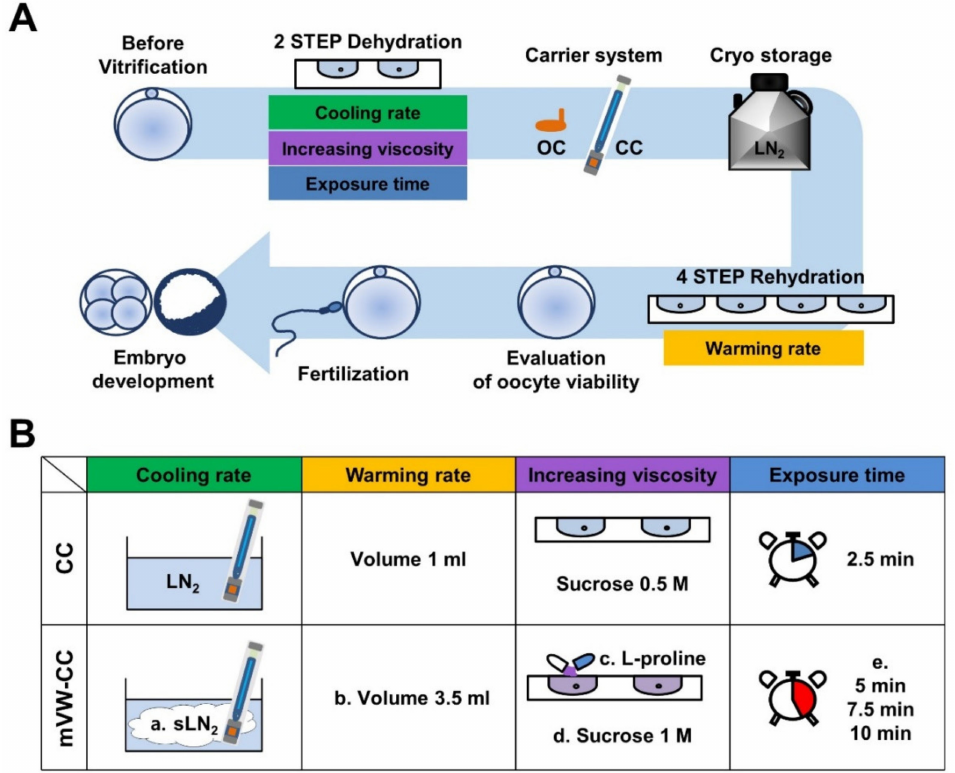
Figure 1. Schematic representation of the vitrification and warming procedure using mouse oocytes. ( A ) During vitrification, mature oocytes underwent a two-step dehydration cooling process, and then the oocytes were loaded on two different carrier devices, an open carrier system and a closed carrier system, and immersed in liquid nitrogen. Oocytes were warmed via a stepwise transfer into four sucrose concentration solutions, 0.5, 0.25, 0.125 and 0 M for 2.5 min each. After 2 h of incubation in fertilization medium, oocytes were subjected to insemination. ( B ) The experimental design for four different modifications during the procedure: (a) increased cooling rate by slush liquid nitrogen; (b) increased warming rate by expanding the volume of first warming solution; (c,d) Increased viscosity by supplementation of L -proline and increased sucrose concentration; (e) increase in exposure time to cryoprotective